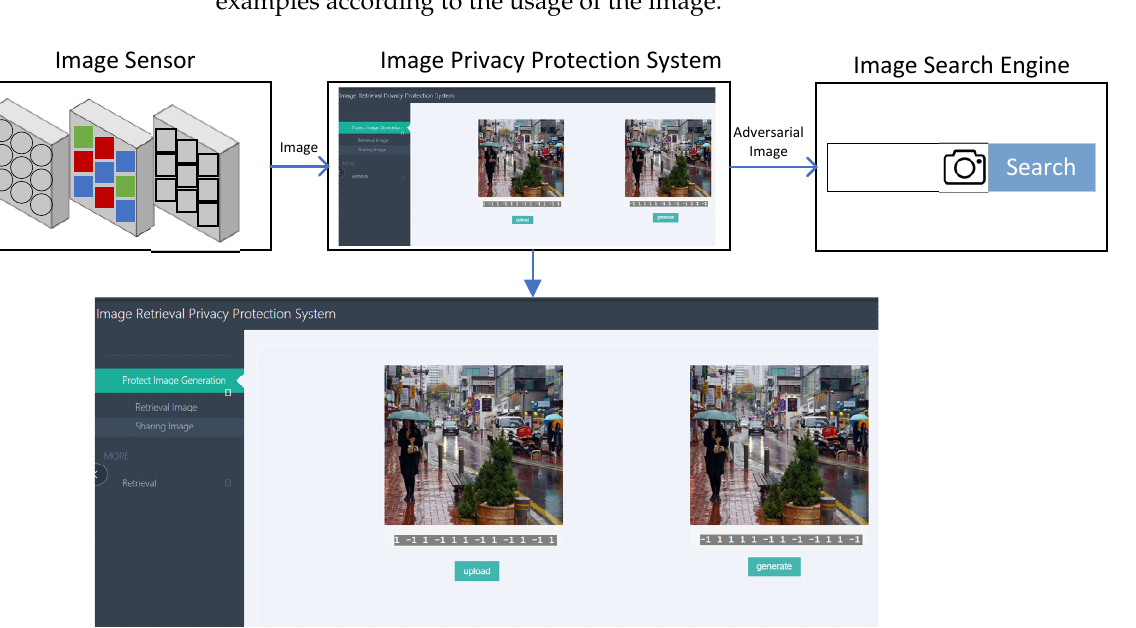
Figure A1. Above figure shows the industrial application scenario of the adversarial attack method. In order to protect the privacy of the images collected by the image sensor, the output image of the image sensor is input into the image privacy protection system to generate adversarial examples. It can be seen from the figure that the hash code of the original image is different from the hash code of the adversarial example. So, using adversarial examples for image retrieval can protect the semantics of the original image’s